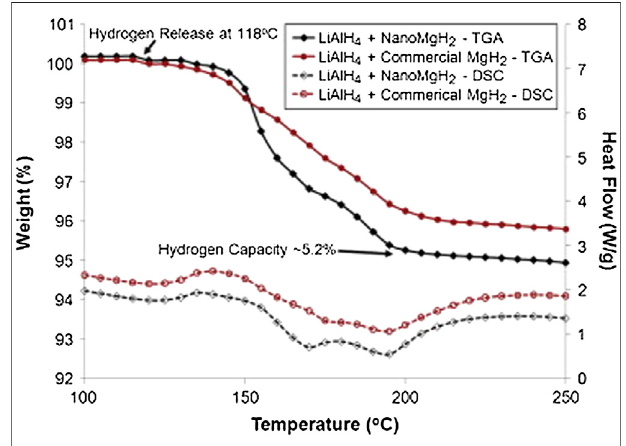
FIGURE6| ComparisonofTGA/DSCmechano-chemicallymilledfor2 h for LiAlH 4 -MgH 2 and LiAlH 4 – nanoMgH 2 (Vittetoe et al., 2009).